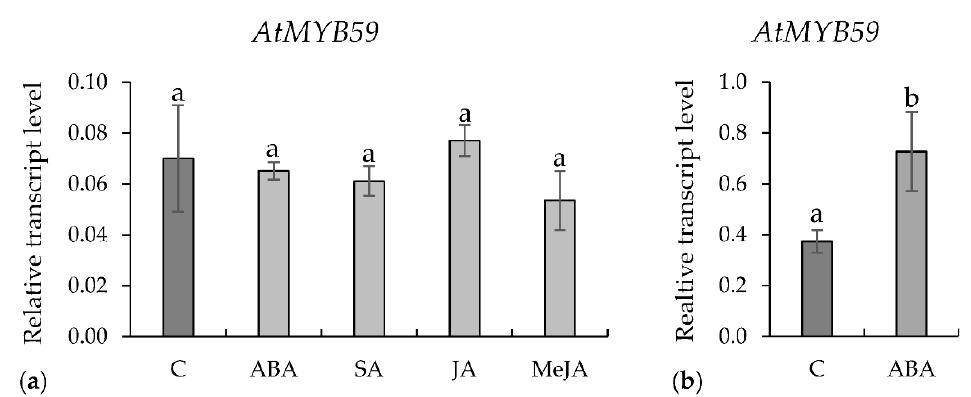
Figure 3. The relative expression level of AtMYB59 gene in wild-type A. thaliana after phytohormones treatment: ( a ) relative transcript levels in roots treated with ABA, SA, JA, or MeJA (100 µM concentration each); and ( b ) relative transcript levels in leaves treated with ABA (100 µM). The bars show mean values ± standard deviation. a, b homogenous groups ( p < 0.05; ANOVA; LSD).